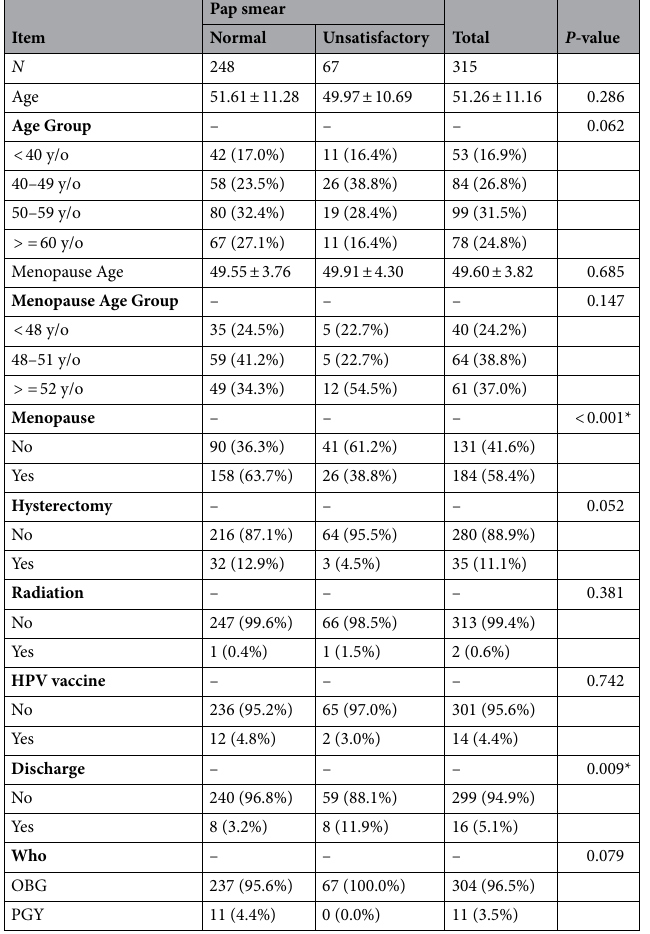
Table 1. Patient Demographics (n = 315). Data are presented as n or mean ± standard deviation. * p -value < 0.05 was considered statistically significant after test. OBG: obstetrics and gynecology; PGY: postgraduate years 1 and